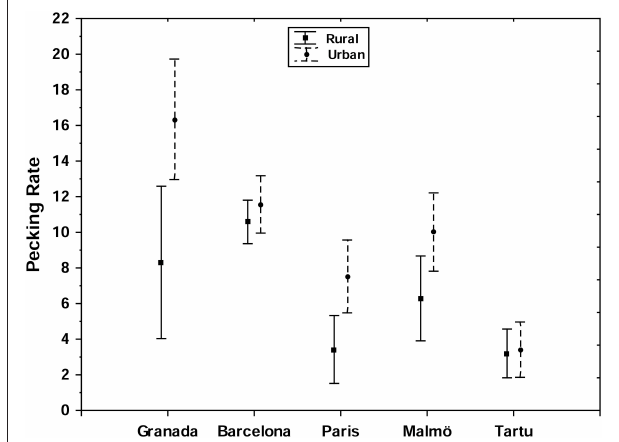
FIGURE 2 | Between-individual variation (mean with standard error) in pecking rate along habitats (urban vs. rural) and localities (see Table 5 ). Pecking rate is number of peckings during 15s.